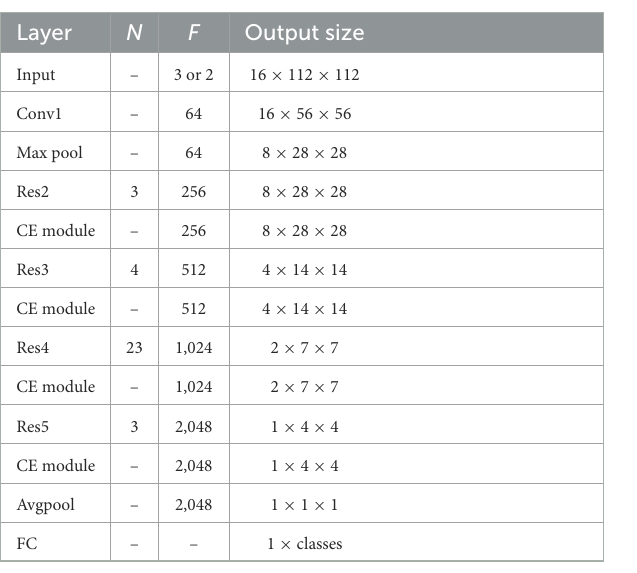
TABLE 1 Network size information.